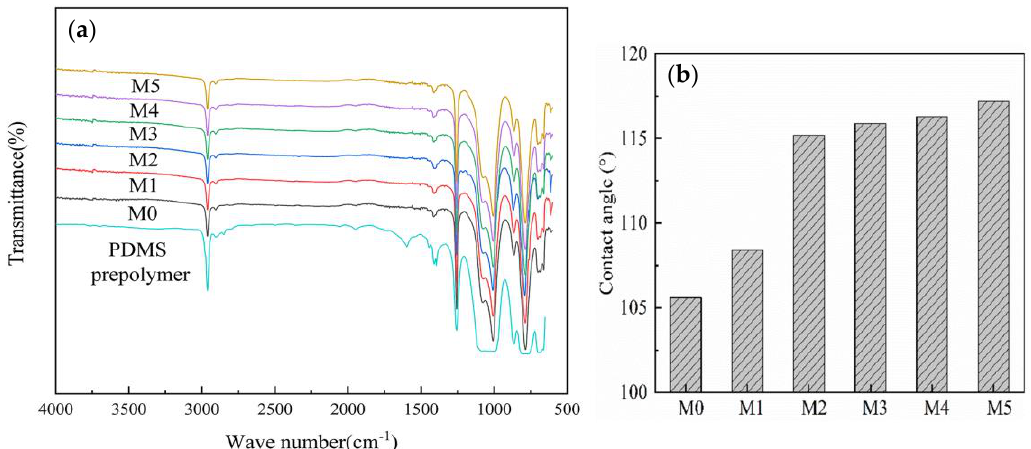
Figure 7. ( a ) FT-IR spectra of PMDS prepolymer and M0 – M5; ( b ) contact angles of M0 – M5.